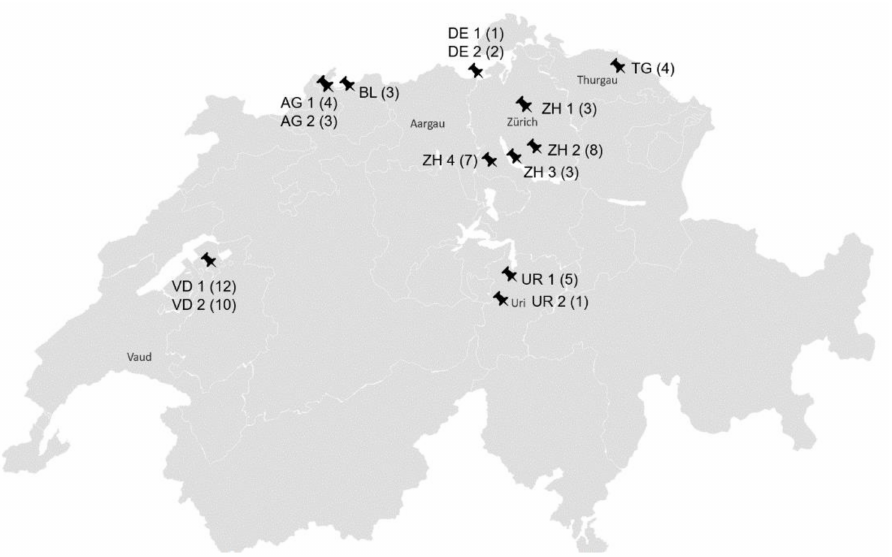
Figure 2. Geographical distribution of the stables; AG: Aargau; BL: Baselland; DE: Germany; TG: Thurgau; UR: Uri; VD: Waadt; ZH: Zurich; ZH 1 (3): canton, stable number, number of sampled horses per